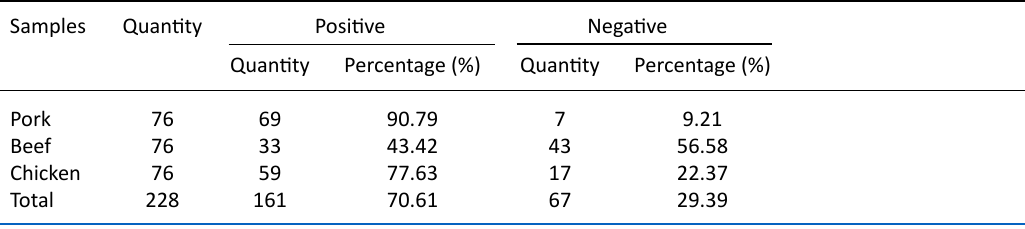
Table 1. The percentage of Salmonella spp. detection in raw meat samples